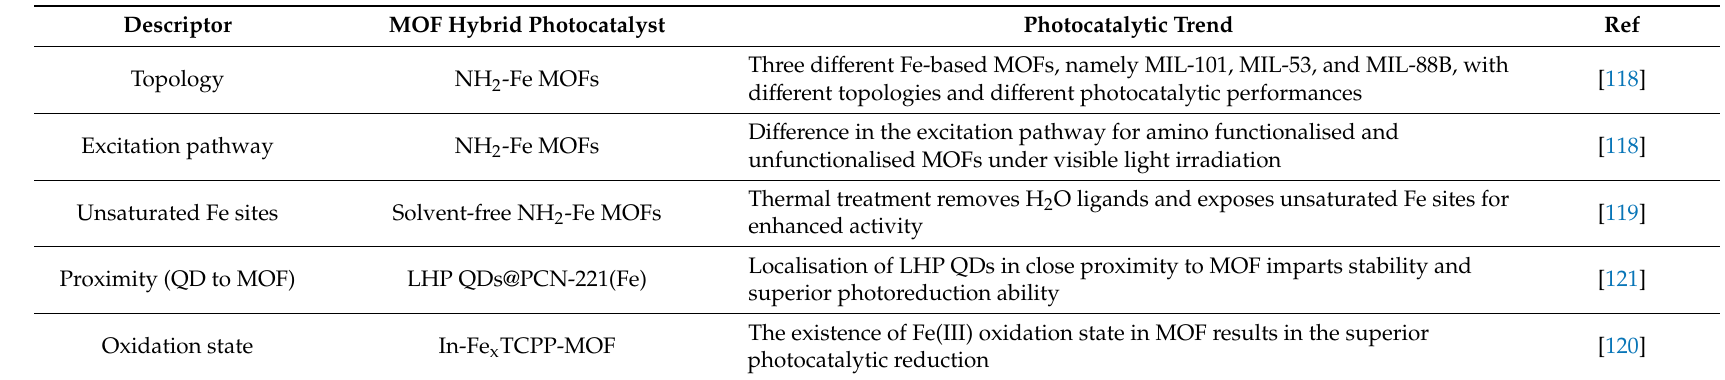
Table 5. Catalytic descriptors enlisting non-noble-metal species incorporated within MOFs for photocatalytic CO 2 utilisation.